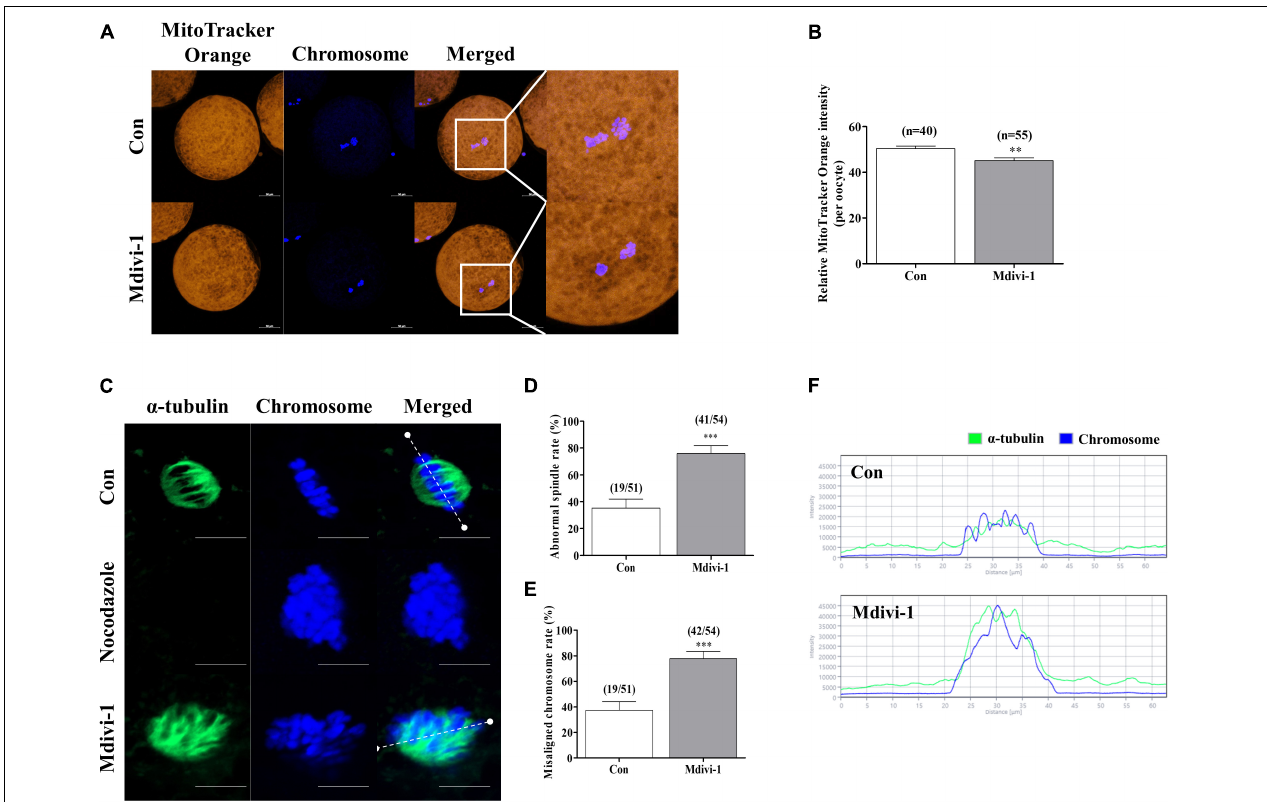
FIGURE 4 | Effects of mitochondrial division inhibitor 1 (Mdivi-1) on spindle assembly in mature porcine oocytes. (A,B) Representative images of mitochondrial activation in the control and Mdivi-1-treated groups. Orange: mitochondria; blue: chromosome. Scale bar: 50 µ m. (B) Quantitative analysis of mitochondria activation in the control and Mdivi-1-treated groups. (C) Representative images of spindle morphology and chromosome alignment in the control and Mdivi-1-treated groups. Green: α -tubulin; blue: chromosome. Scale bar: 10 µ m. Abnormal spindle (D) and misaligned chromosome (E) rates of mature oocytes in the control